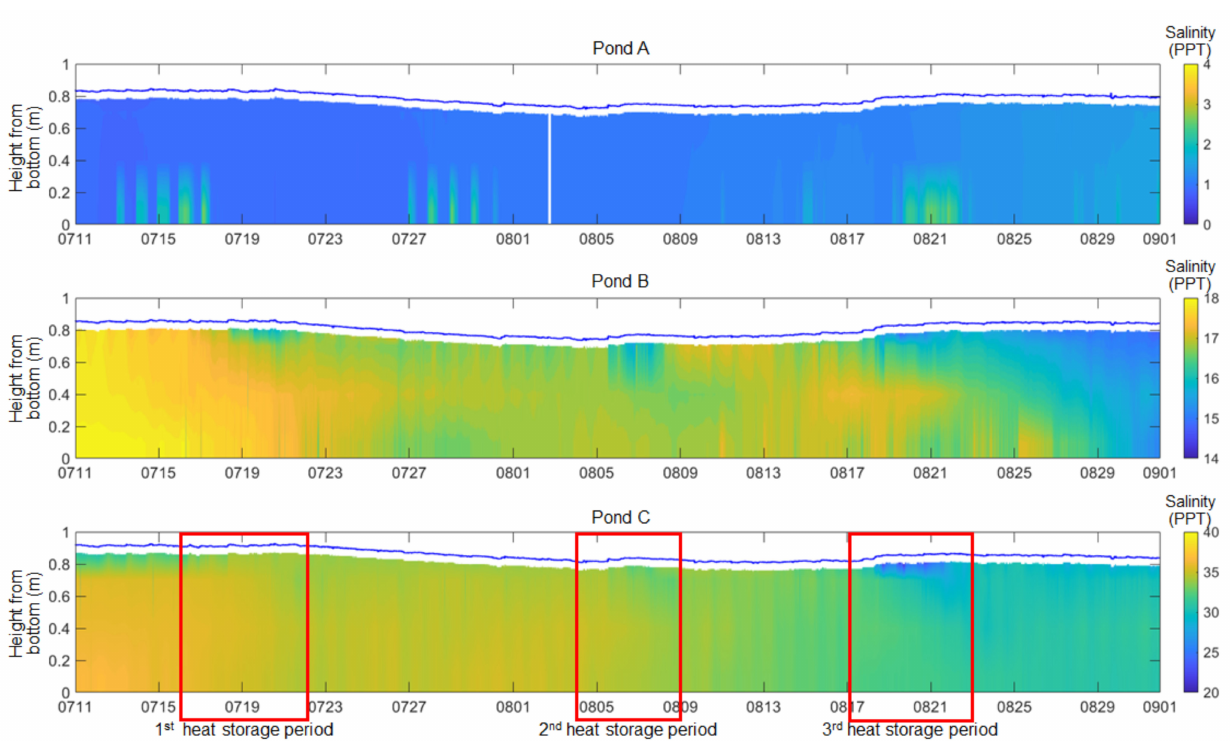
Figure 4. Water temperature variation time-series. The blue line indicates the water level fluctuation. Red rectangles indicate the heat storage period in Pond C.